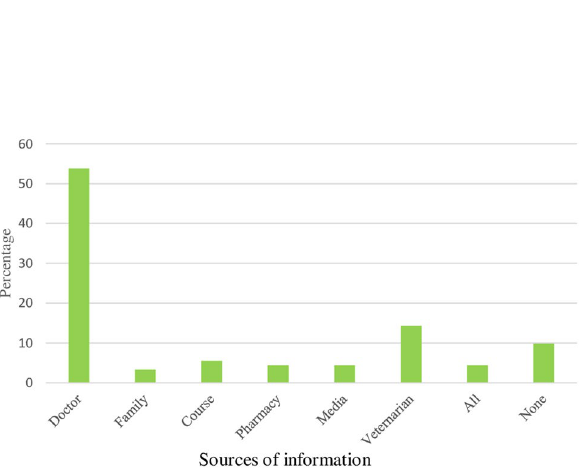
Figure 3. Sources of information on ABR and